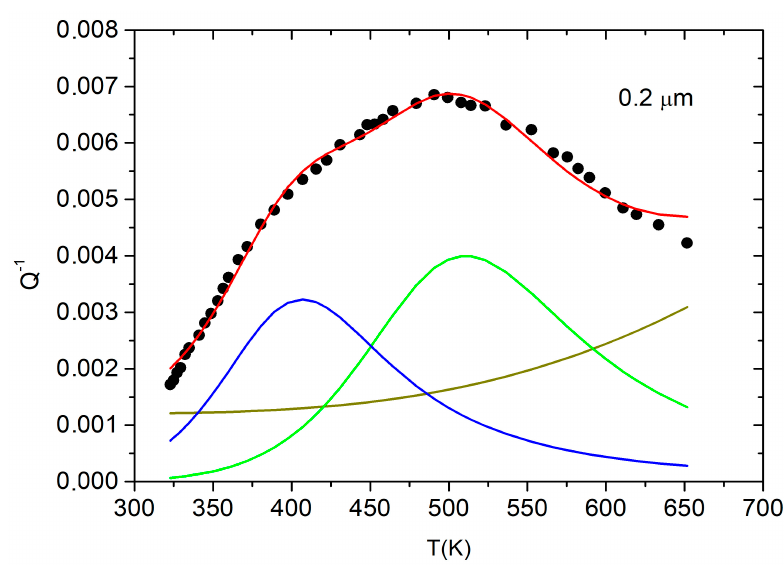
Figure 3. Q − 1 vs. temperature curve of a 0.2 µ m thick film deposited on a silicon substrate after the subtraction of the substrate contribution. Experimental data are fitted as the sum (red curve) of an increasing exponential background (dark green curve), and two peaks with activation energies of 0.51 eV and 0.56 eV (green and blue curves) [11].